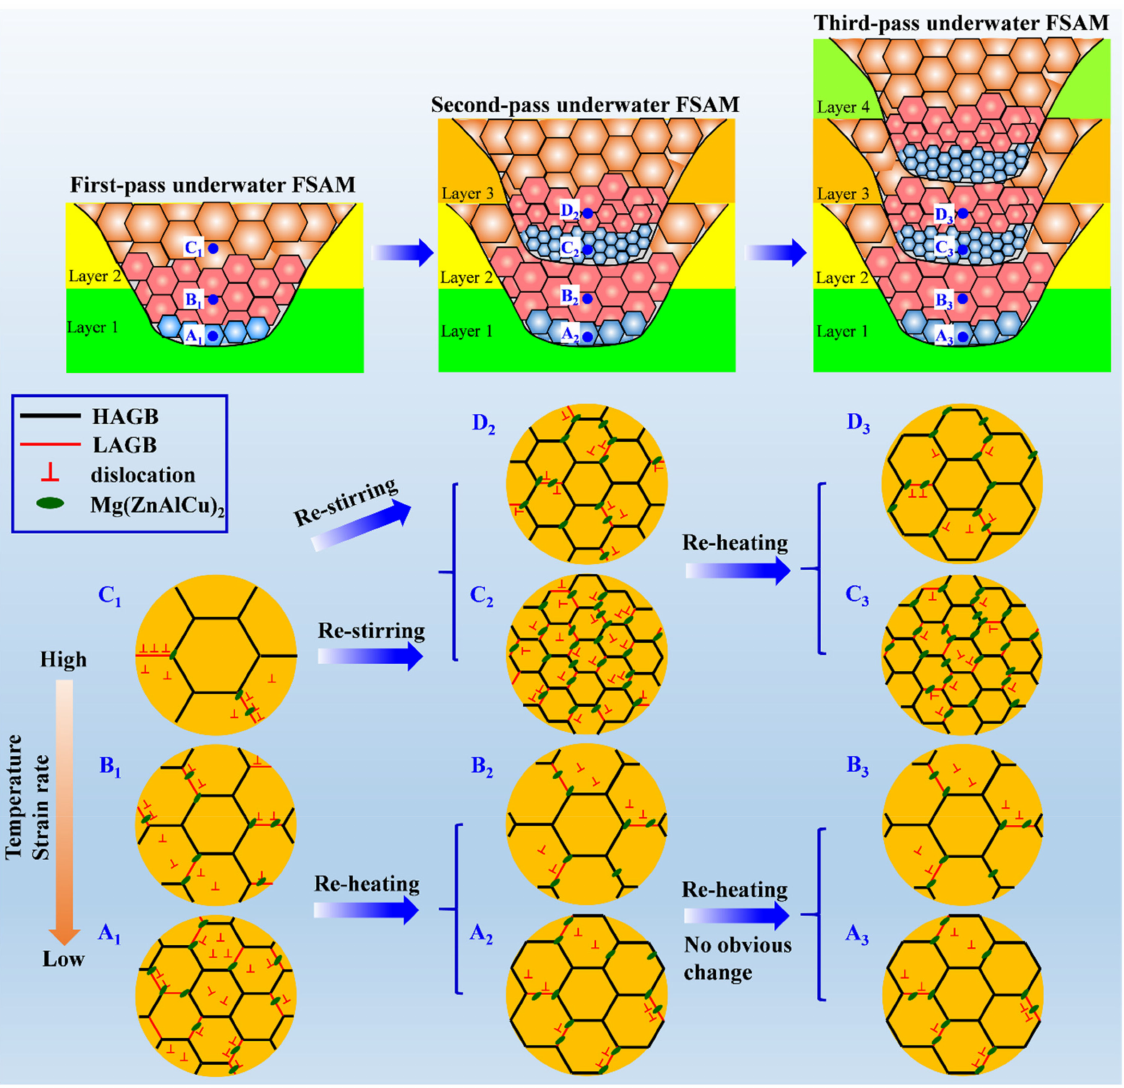
Figure 9. Schematic of microstructural evolution during underwater FSAM. The specified positions of the microstructures are marked with blue dots and letters (A 1 , A 2 , A 3 , B 1 , B 2 , B 3 , C 1 , C 2 , C 3 , D 2 , D 3